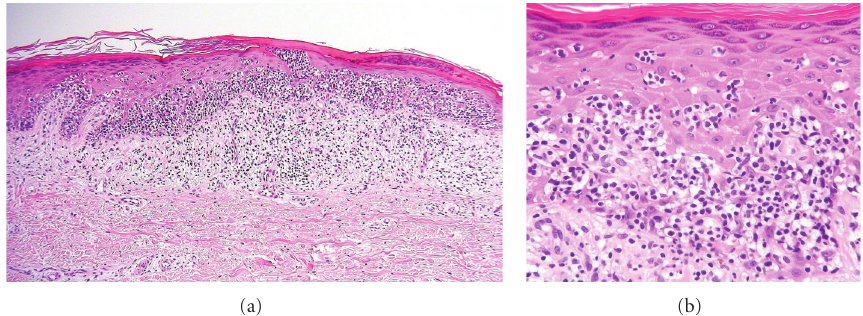
Figure 2: Hematoxylin and Eosin stain shows massive band-like infiltrates of atypical lymphocytes with prominent epidermotropism within a hyperplastic epidermis ((a) x100, (b)